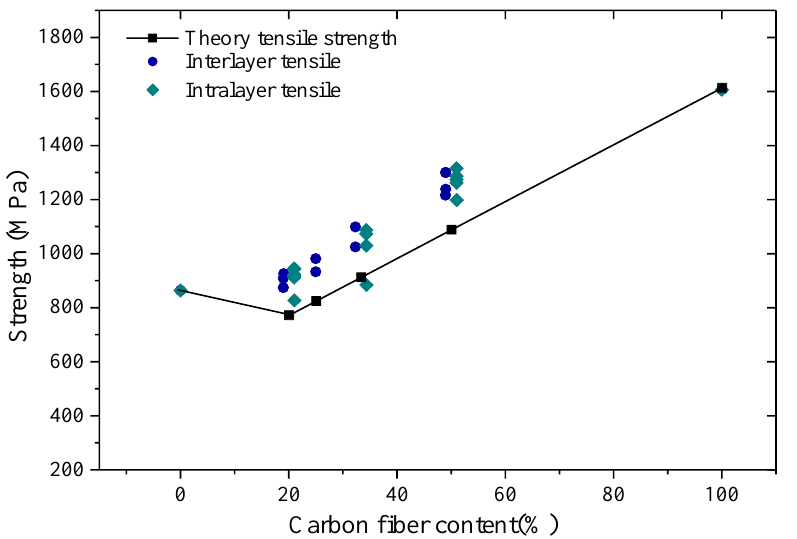
Figure 22. Theoretical and experimental strength of interlayer and intralayer hybrid composites.